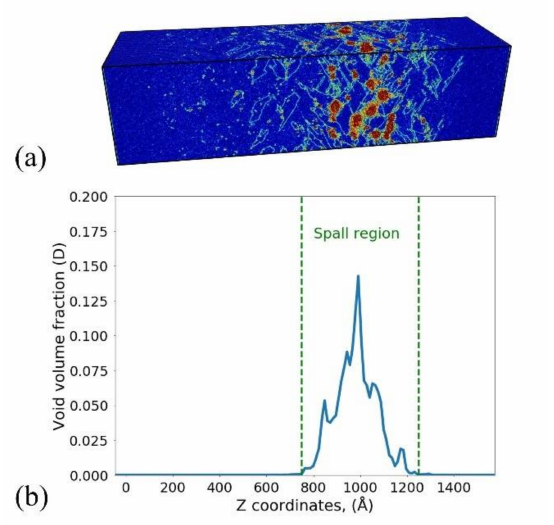
Figure 1. ( a ) Snapshot of (001) single-crystal Ta at the time associated with a maximum in void number where atoms are colored based on the centrosymmetric parameters [60], ( b ) distribution of the void volume fraction along the length of the simulation cell (Z